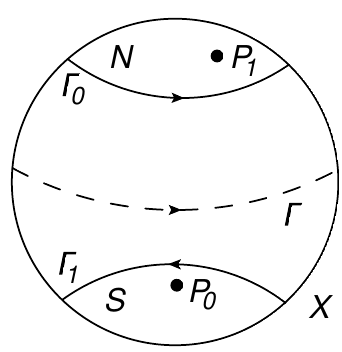
Figure 1 . The Riemann sphere X in twistor space corresponding to a spacetime point x . We consider a twistor function ˇ f ( Z α ) with poles P i contained in the regions N and S around the north and south poles. The contour Γ separates these two